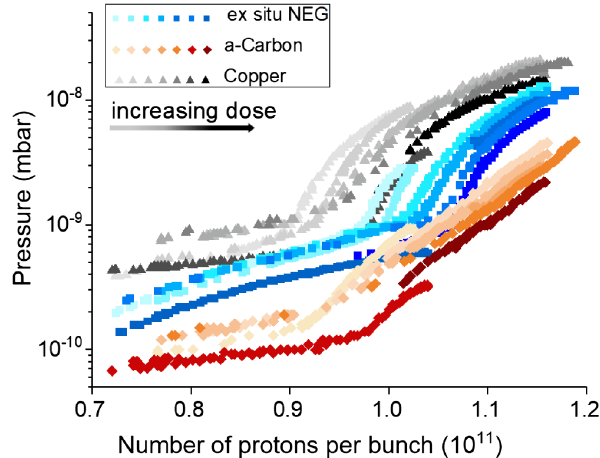
FIG. 9. Accumulated electron dose effect on the electrical signals at 450 GeV as a function of the number of protons per bunch, in logarithmic scale.